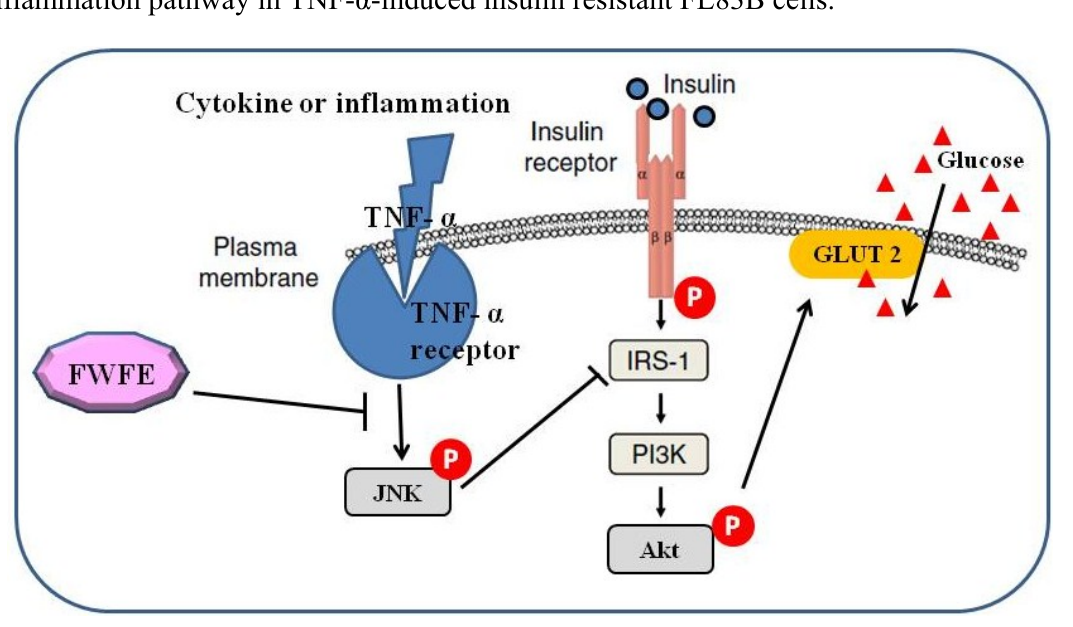
Figure 5. Postulated mechanism of FWFE on modulating insulin signaling and inflammation pathway in TNF- α -induced insulin resistant FL83B